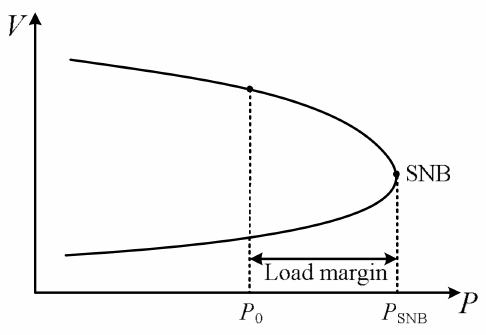
Figure 1. The P - V curve and the saddle-node bifurcation (SNB)